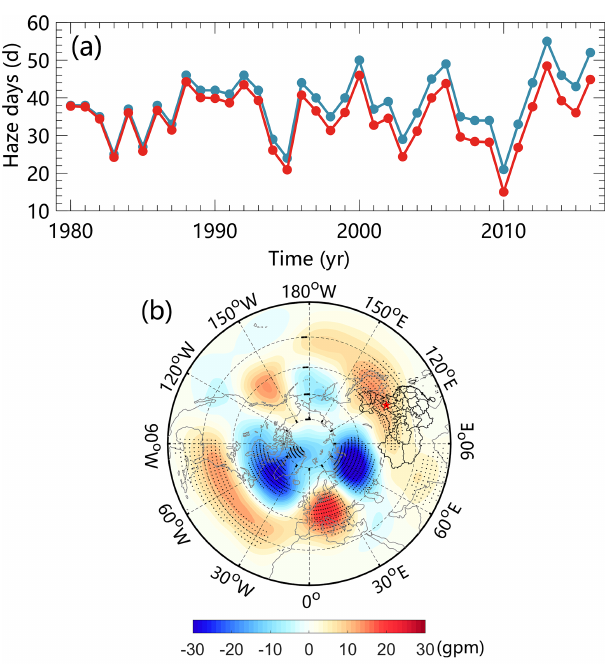
Figure 1. (a) Time series of winter haze days (blue) and detrended winter haze days (red) in Beijing from 1980 to 2016. To aid visual- ization, a fixed value is added to all the detrended data so that the first values of both series coincide. (b) Regressed Z500 anomalies (shading; units: gpm) against the detrended winter haze days. The dotted areas show values that are above the 95% confidence level based on a two-sided Student’s t test. For all plots in this study, the red star denotes the location of